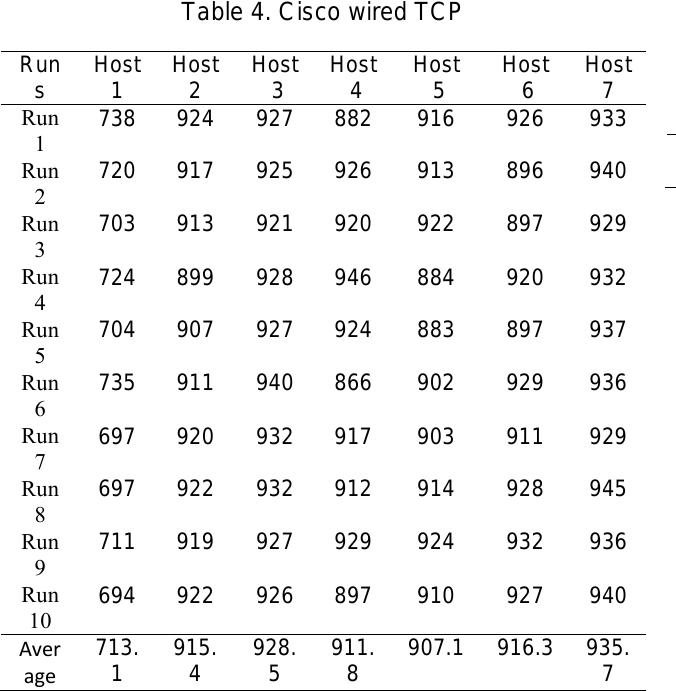
Figure 4. Maximum Data Requirements